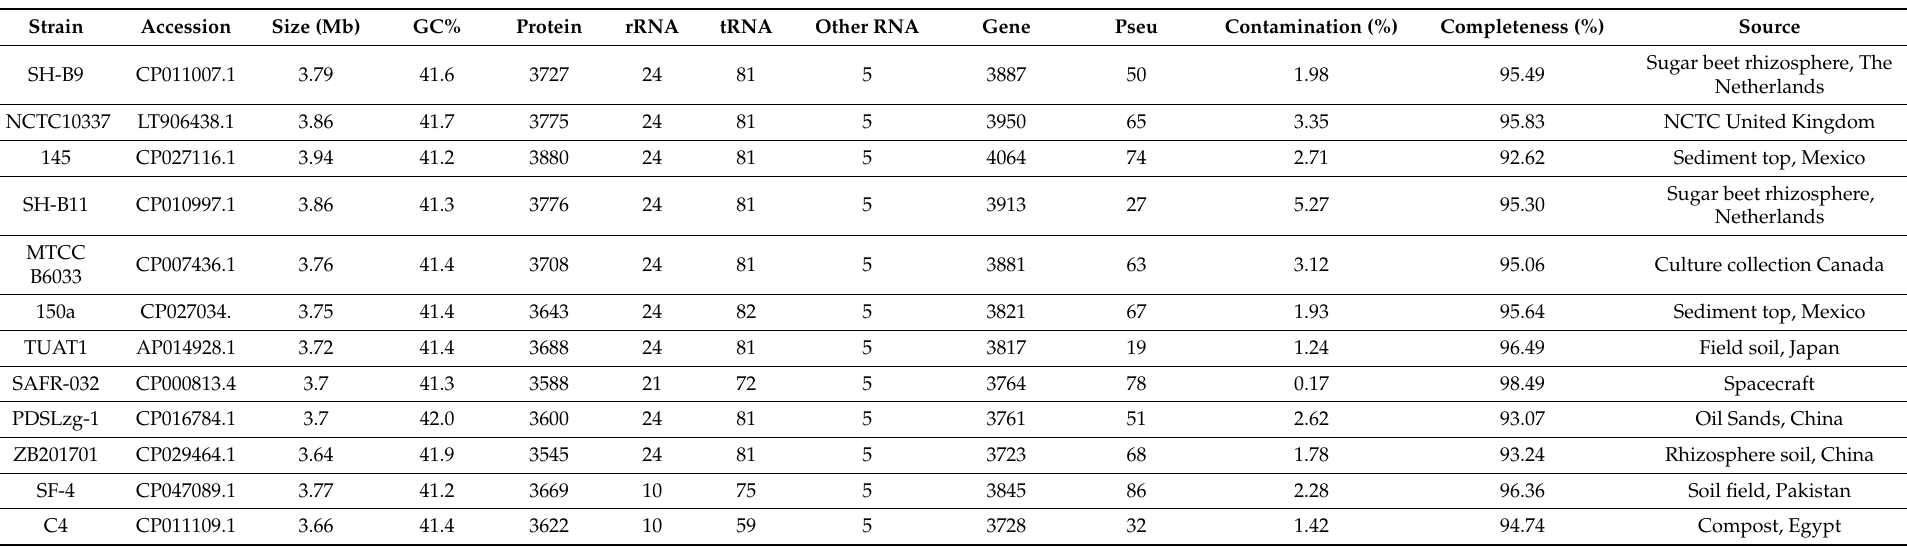
Table 2. Comparative genome features of 12 B. pumilus